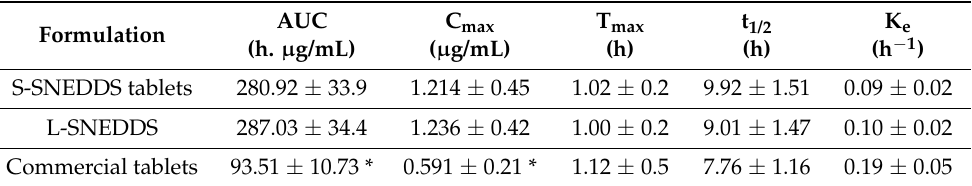
Table 5. Pharmacokinetic parameters of finasteride loaded SNEDDS after oral administration to rats. The results are presented as mean ± SD. * p < 0.05 compared with the S-SNEDDS tablets and